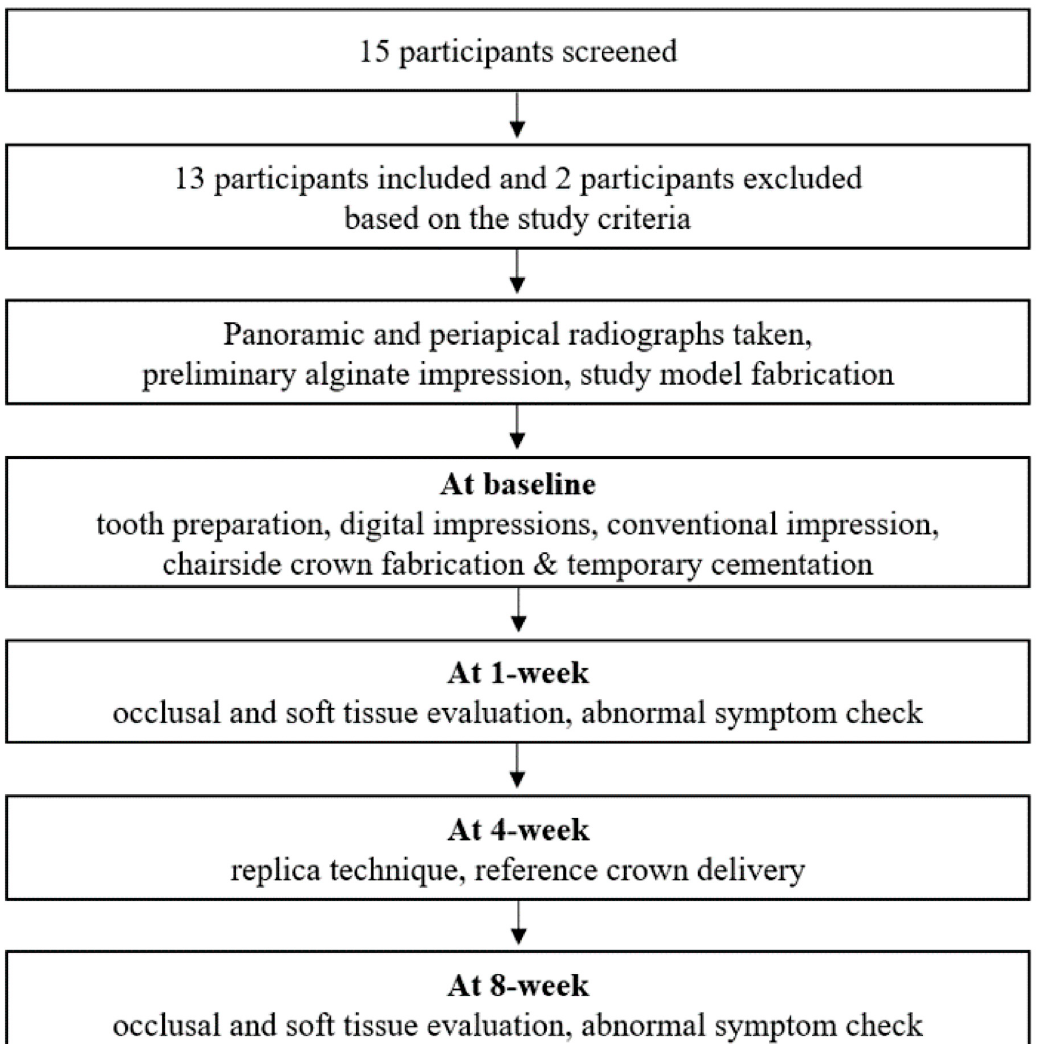
Figure 1. Flow-chart depicting visits, timeline, evaluation items.